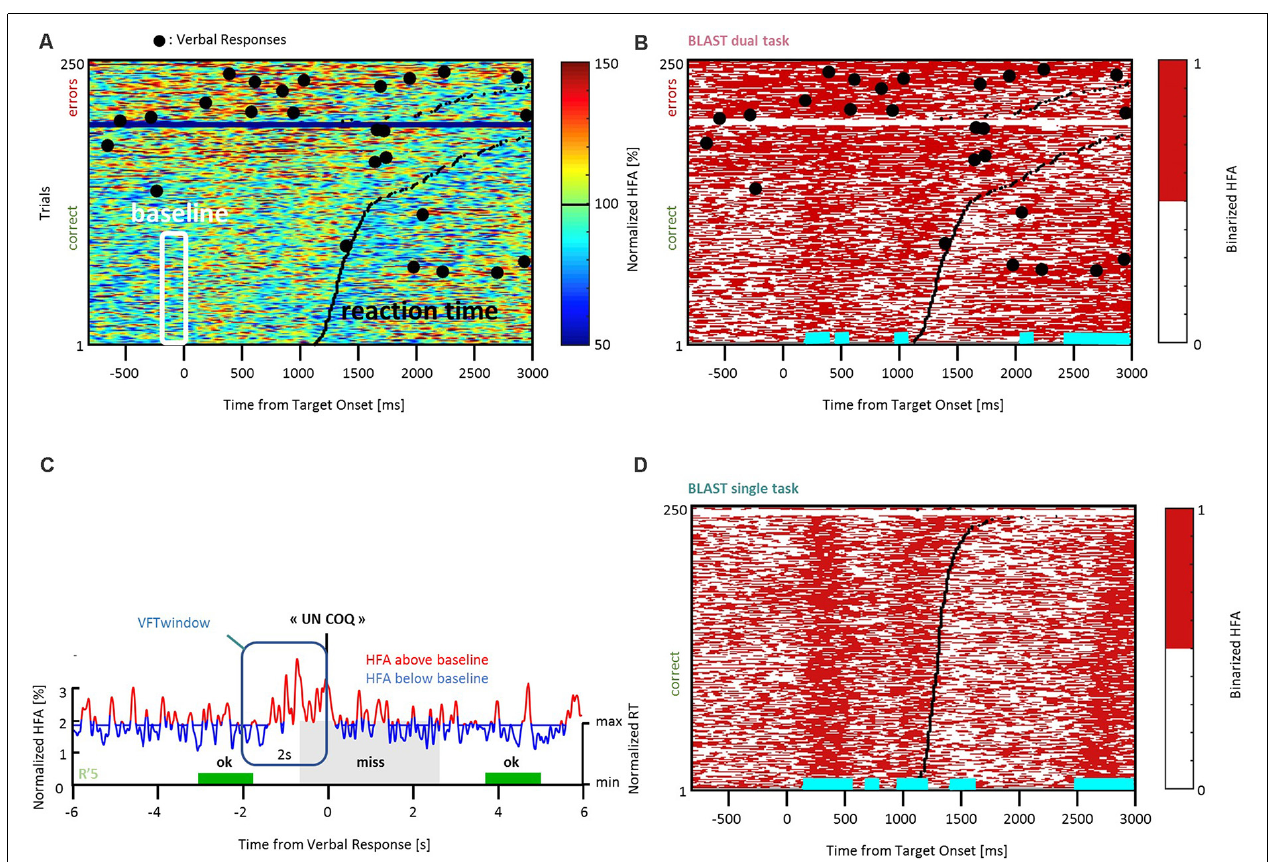
FIGURE 2 | Methodological procedure. (A) An example of neural response recorded in the left Precentral Gyrus during T1 in the DT condition, across all trials. Every row of the matrix corresponds to one trial, and HFA is color-coded as a function of time (x-axis). Trials are sorted by reaction time (black line) for correct and incorrect responses (in the lower and upper part of the matrix, respectively). HFA is expressed as a percentage of the average HFA value for that particular iEEG site, across the entire recording. Large black dots indicate verbal responses to T2. The white frame indicates HFA values used to estimate a quiescent baseline state (the prestimulus baseline during the 50 fastest correct trials of T1). The median of all HFA values within that white frame, Vmed, was used to create the binarized version of the matrix shown in (B) . (B) Binarized version of the same matrix (DT condition). By definition, “off” samples in white (resp. “on” samples, in red) have an HFA value below (resp. above) Vmed. During the baseline, the signal goes through a noisy succession of “on” and “off” states in equal number (at least, and by definition, for the best 50% trials); at other latencies, horizontal cyan lines indicate latencies with an abnormally high (or low) proportion of “on” samples across the 50% fastest correct trials (see “Materials and Methods” section for details). By construction, cyan lines indicate time-windows during which the neural population is not available for T2. (C) An example of HFA signal measured during a verbal response (“un coq” or “a rooster”). Values above Vmed (“on” samples) are shown in red, “off” samples are shown in blue. Several of our analyses measured the proportion of “on” samples within “T2-windows”, defined as the 2 s intervals before the response (vertical frame, in blue). T1 performance is color-coded for three consecutive trials (two hits in green, one miss in gray), and the height of the colored rectangles is proportional to reaction time (“min” = minimum reaction time across the entire experiment, same for “max”). (D) Binarized trial matrix for the same iEEG site as in (B) but in the ST condition. The comparison between (B) and (D) is illustrative of a strong interference between T1 and T2. HFA, High-Frequency